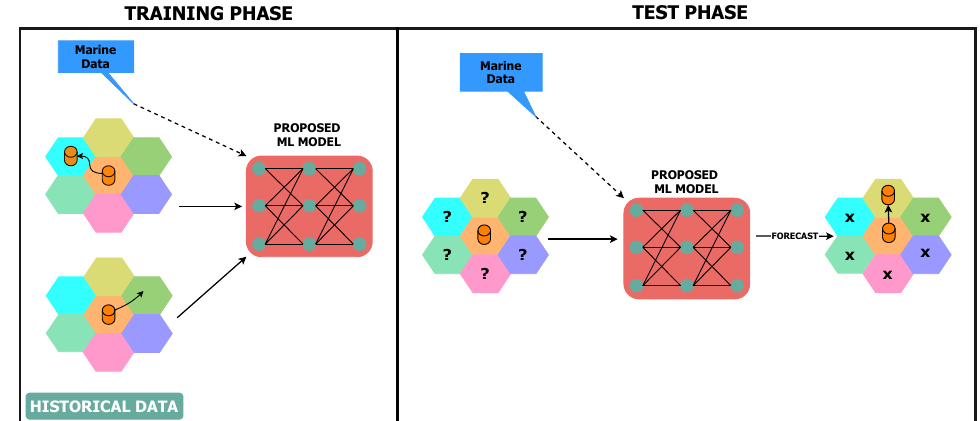
Figure 2. Overview of the proposed